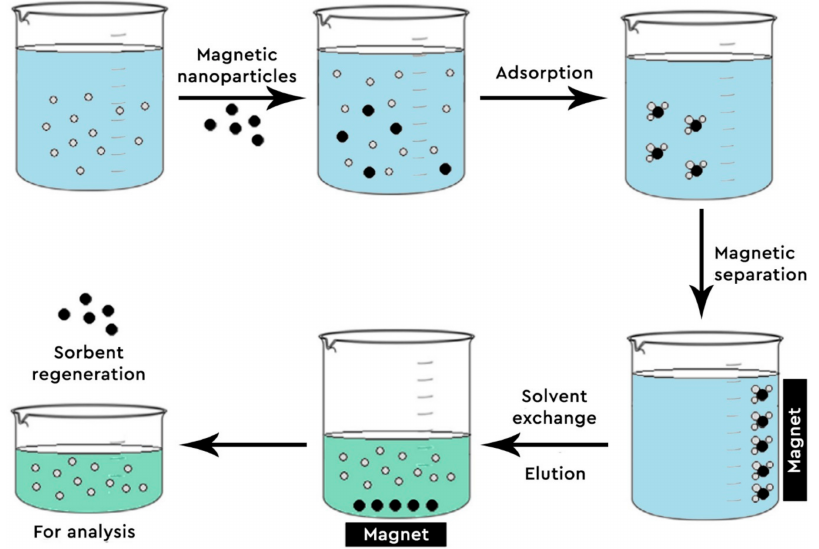
Figure 2. Steps of Magnetic Solid Phase Extraction